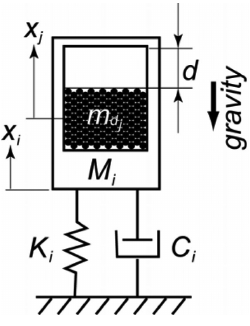
Fig. 2. Approximate SDOF model with particle damper for i-th